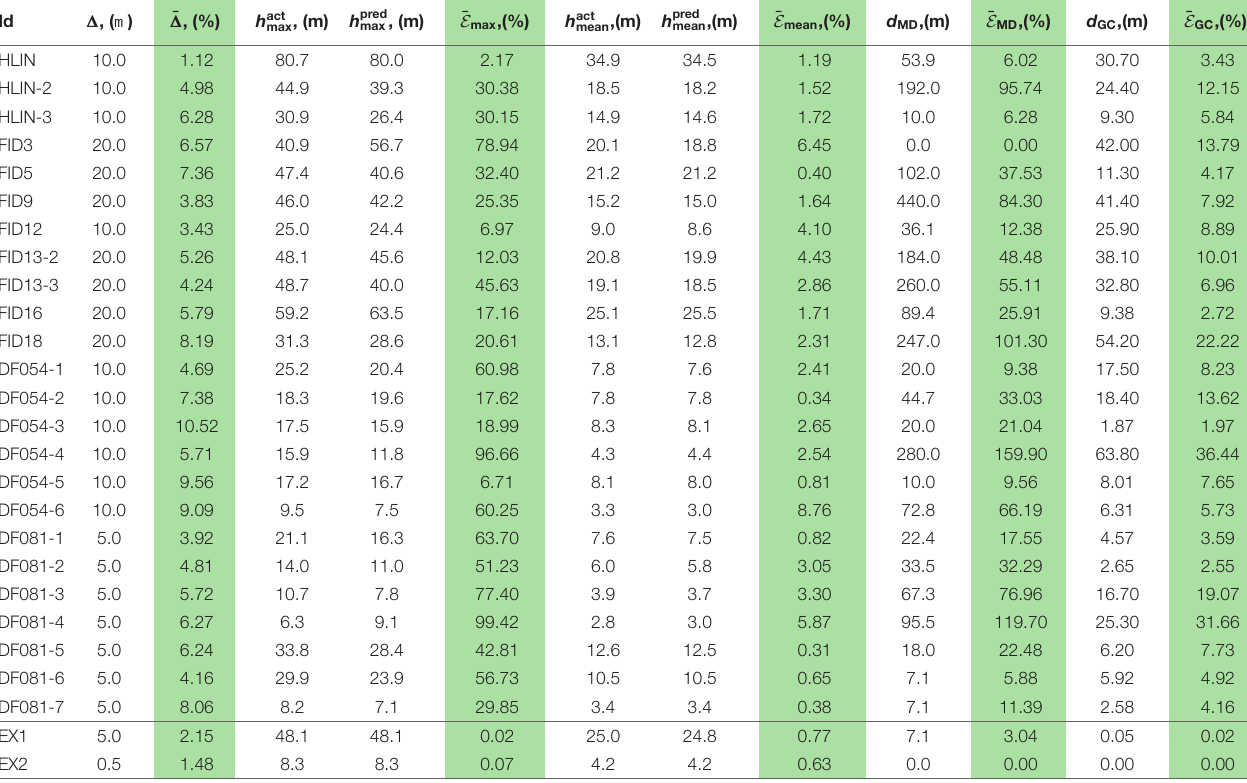
TABLE 2 | DEM grid size, depth-related quantities, and positional offsets of the maximum depth and gravity centers between the predicted and actual